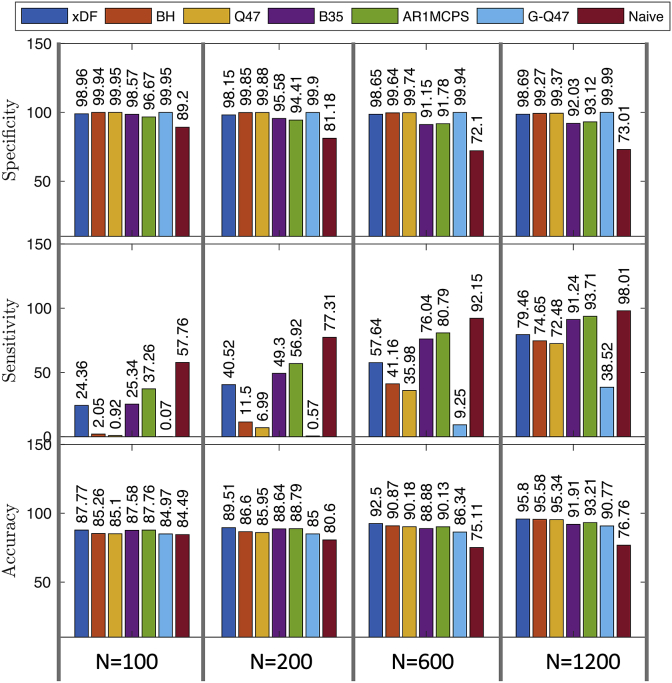
Performance of testing ρ=0 at level α=0.05 on 5000 simulated correlation matrices (114×114, matching Yeo atlas) with 15% non-null edges (see Section S3.5). From top to bottom, specificity, sensitivity and accuracy (sum of detections at non-null edges and non-detections at null edges) are shown. Specificity (i.e. FPR control) is good for xDF, BH, Q47 and G-Q47, and sensitivity increases with time series length; accuracy is best for xDF, closely followed by BH and Q47.